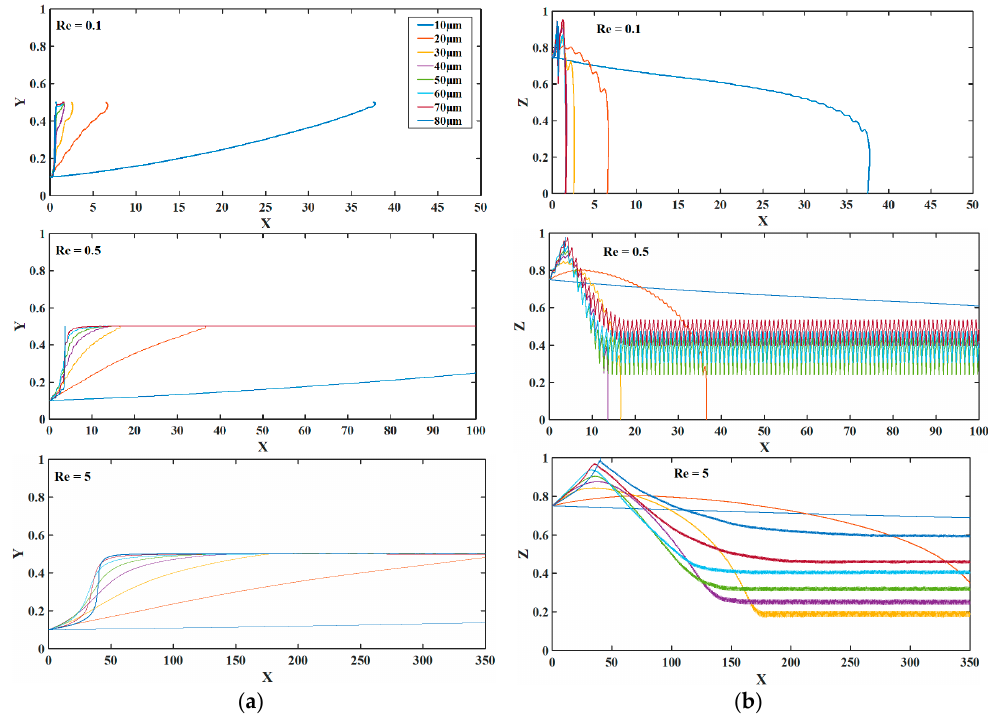
Figure 7. The impact of the pore radius of the perforated surface electrode on the trajectory of microparticle at different Reynolds numbers ( a ) top view; and ( b ) side view. The radius of perforated surface electrode is given in the legend. X, Y, and Z are the dimensionless lengths x/L, y/L, and z/Hch, respectively.